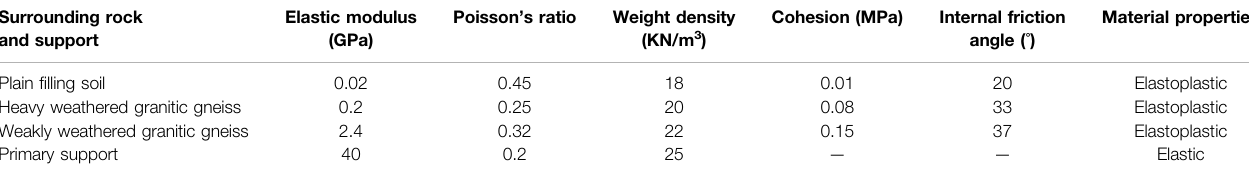
TABLE 2 | Materials employed in the numerical model and physical-mechanical properties.